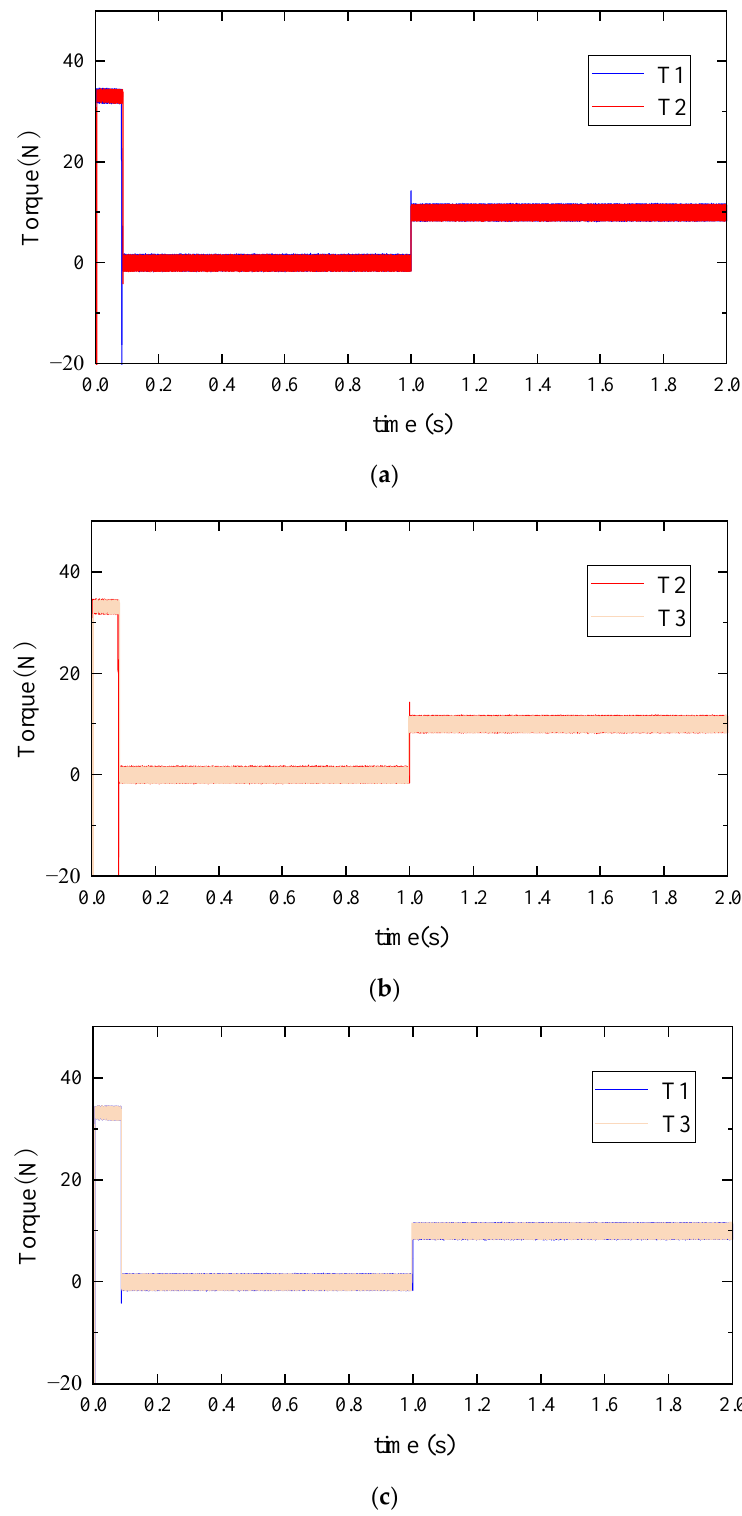
Figure 19. Torque response simulation diagram. ( a ) Comparison of large vector torque response and low – harmonic vector torque response. ( b ) Comparison of low – harmonic vector torque response and improved low − harmonic vector torque response. ( c ) Comparison of large vector torque response and improved low harmonic vector torque response.